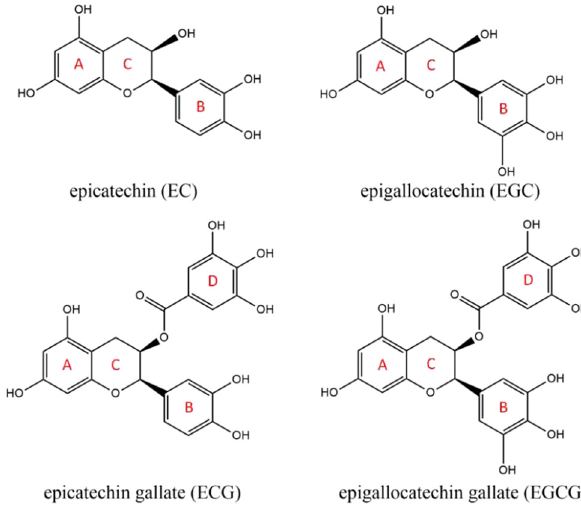
Figure 1: Chemical structures of four catechins ( A represents A - ring, B represents B - ring, C represents C - ring and D represents D - ring )